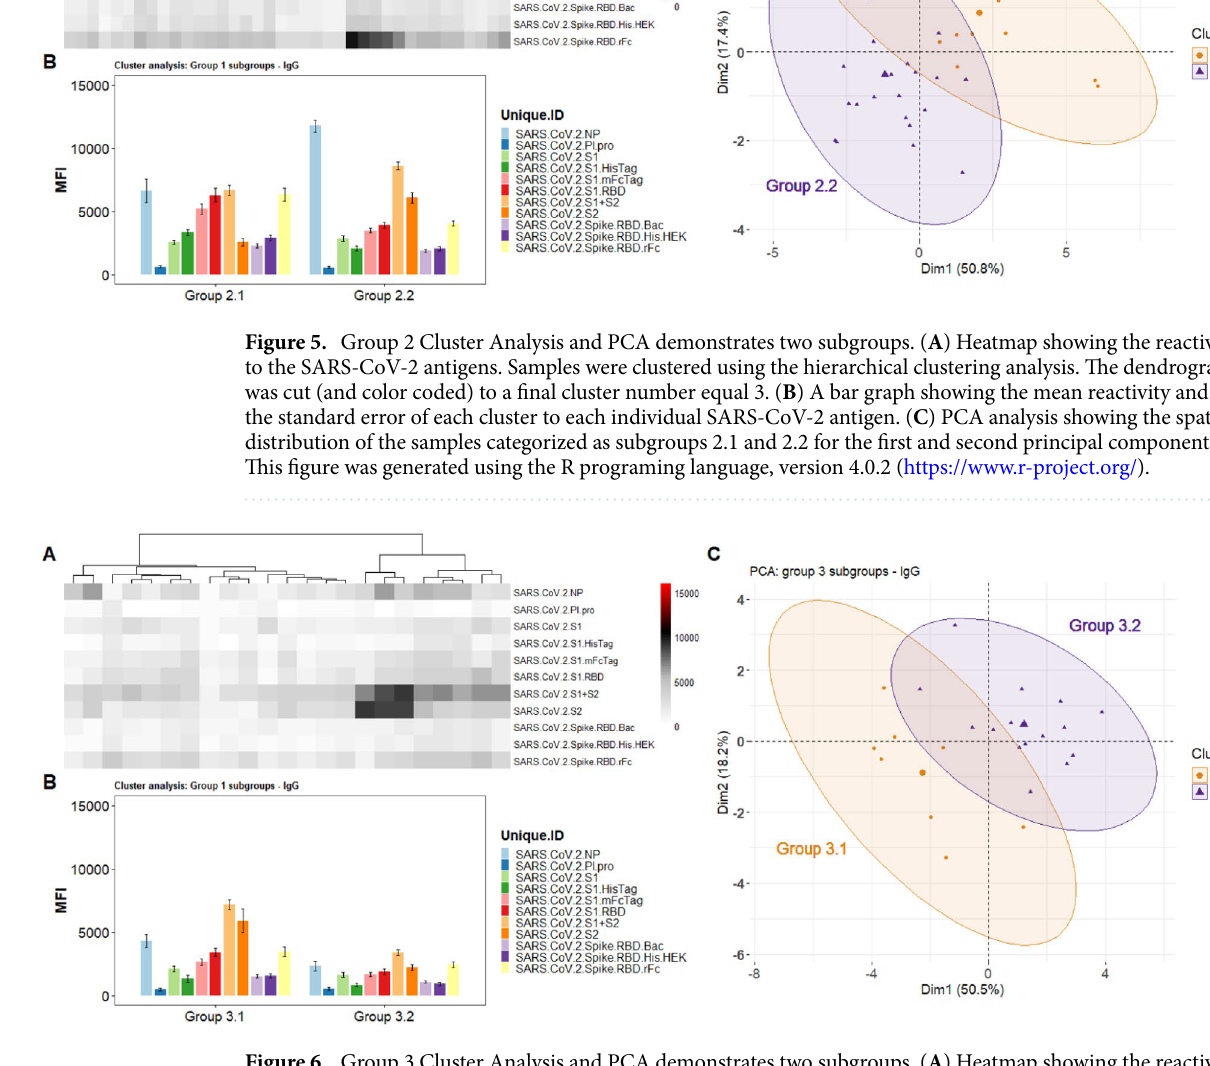
Figure 6. Group 3 Cluster Analysis and PCA demonstrates two subgroups. ( A ) Heatmap showing the reactivity to the SARS-CoV-2 antigens. Samples were clustered using the hierarchical clustering analysis. The dendrogram was cut (and color coded) to a final cluster number equal 3. ( B ) A bar graph showing the mean reactivity and the standard error of each cluster to each individual SARS-CoV-2 antigen. ( C ) PCA analysis showing the spatial distribution of the samples categorized as subgroups 3.1 and 3.2 for the first and second principal components. This figure was generated using the R programing language, version 4.0.2 (https:// www.r- proje ct.